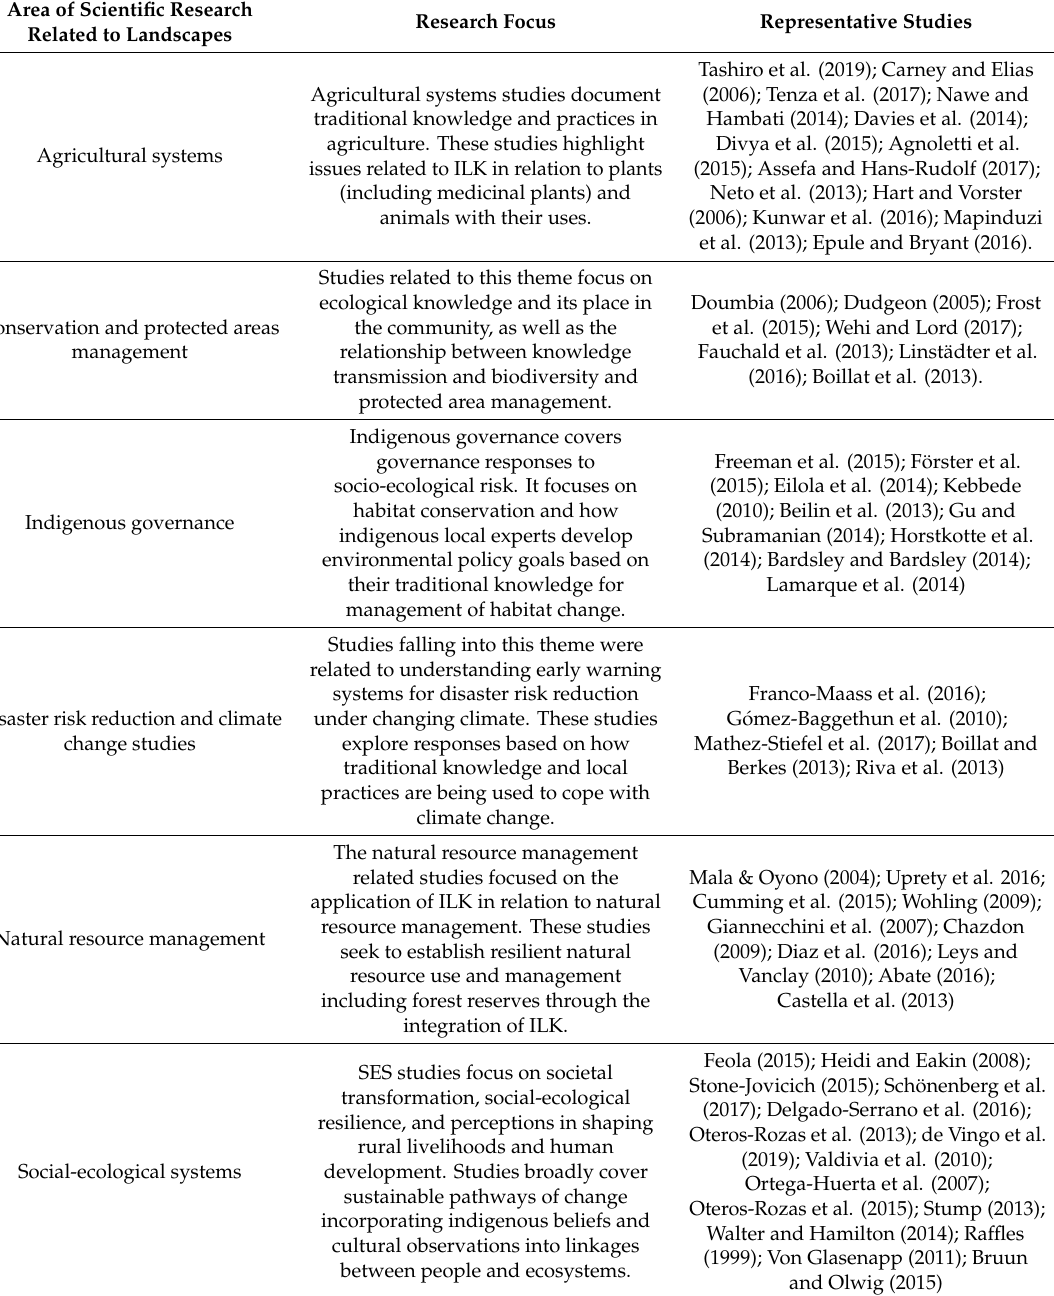
Table 1. Areas of scientific research with ILK